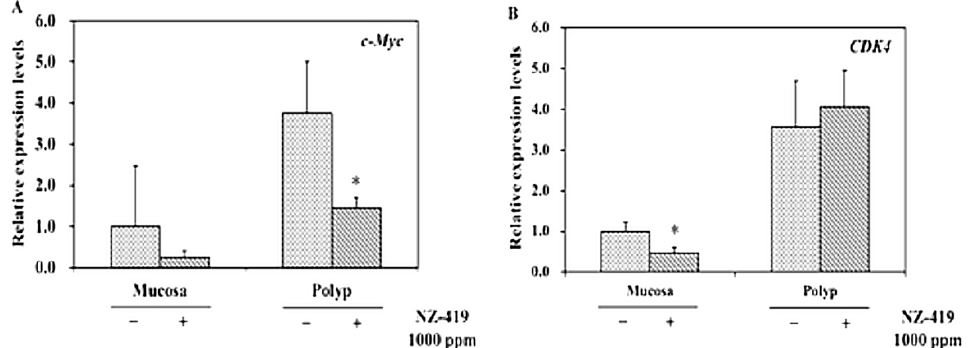
Figure 6. Suppression of c-Myc and Cdk4 in non-polyp intestinal mucosa or / and polyp parts of Min mice treated or not with 1000 ppm NZ-419. The mice received diets containing NZ-419 at the indicated doses for 8 weeks. Quantitative real-time PCR analyses were performed to determine the c-Myc ( A ) and Cdk4 ( B ) mRNA expression levels in the polyps and non-polyp intestinal mucosa of Min mice. The data are normalized to GAPDH and presented as the means ± SD ( n = 3). The basal mRNA expression level in the control was set as 1.0. * p < 0.05 vs. 0 ppm.